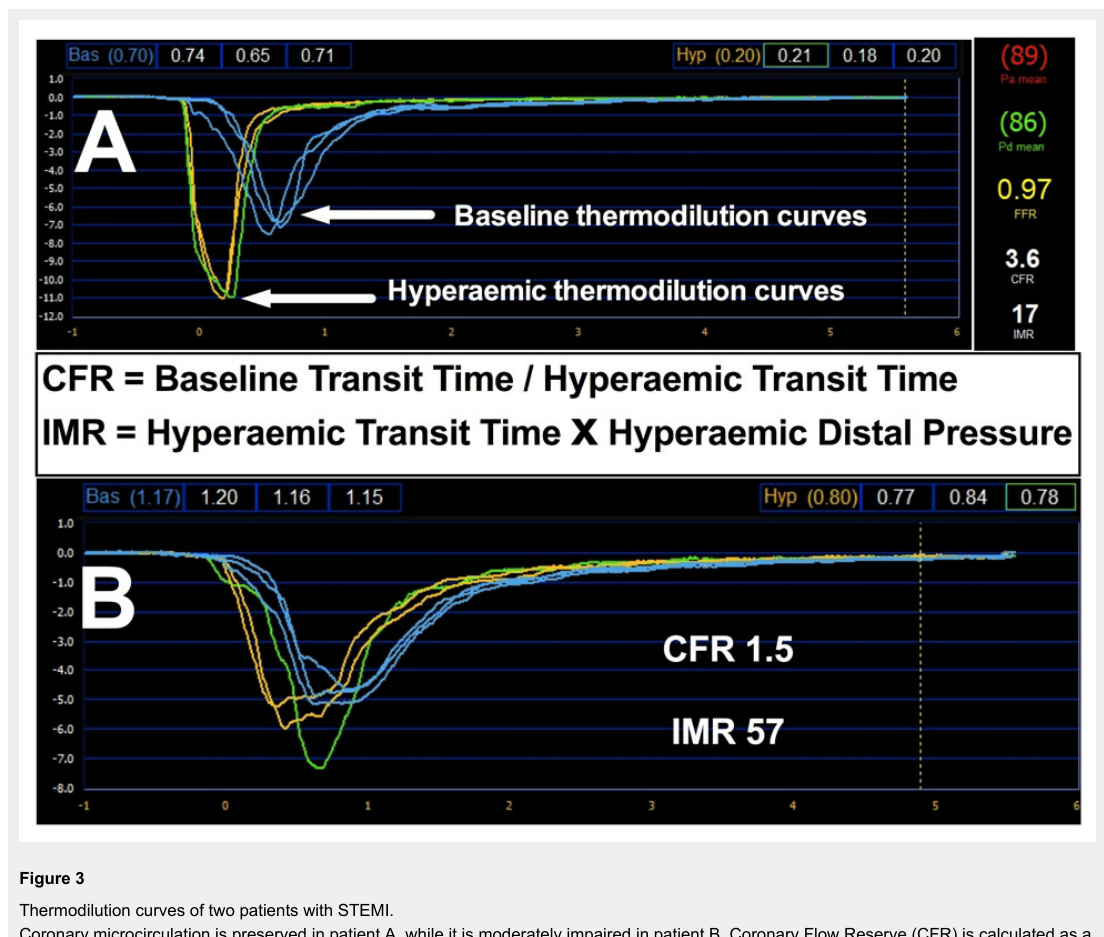
Figure 3 Thermodilution curves of two patients with STEMI. Coronary microcirculation is preserved in patient A, while it is moderately impaired in patient B. Coronary Flow Reserve (CFR) is calculated as a ratio of mean baseline transit time (blue) and mean hyperaemic transit time (yellow). The index of microcirculatory resistance (IMR) is calculated as hyperaemic transit time x mean distal coronary pressure during